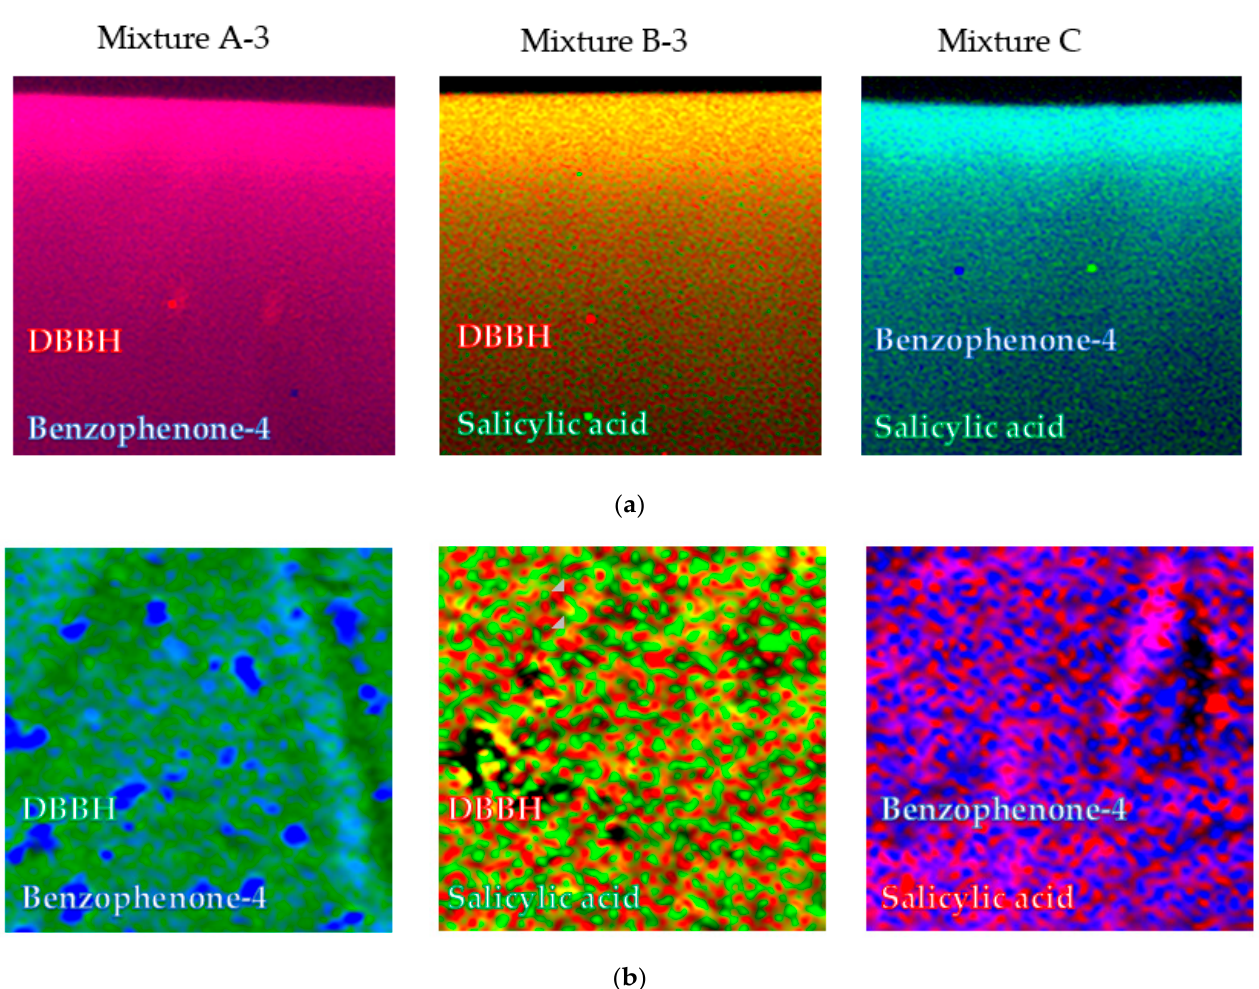
Figure 3. Cross-sectional from the top (image top) to the bulk (image bottom) (50 × 50 µm 2 ) ( a ) and 2D surface (75 × 75 µm 2 ) ( b ) confocal images of different mixtures.